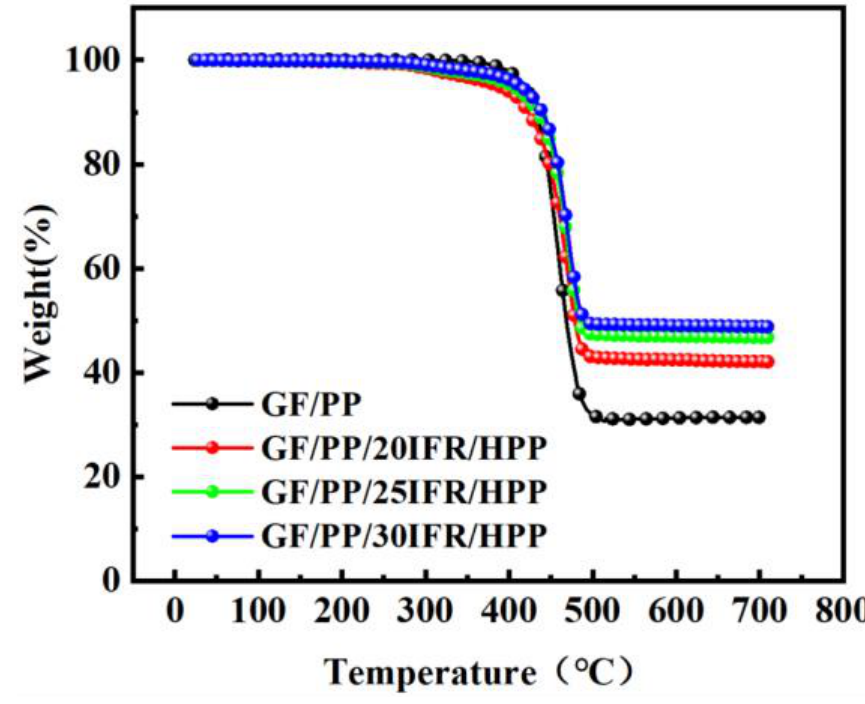
Figure 3. The TG curves of the samples in N 2. Table 2. Thermal decomposition properties of CGF/PP and CGF/PP/IFR/HPP samples in N 2.